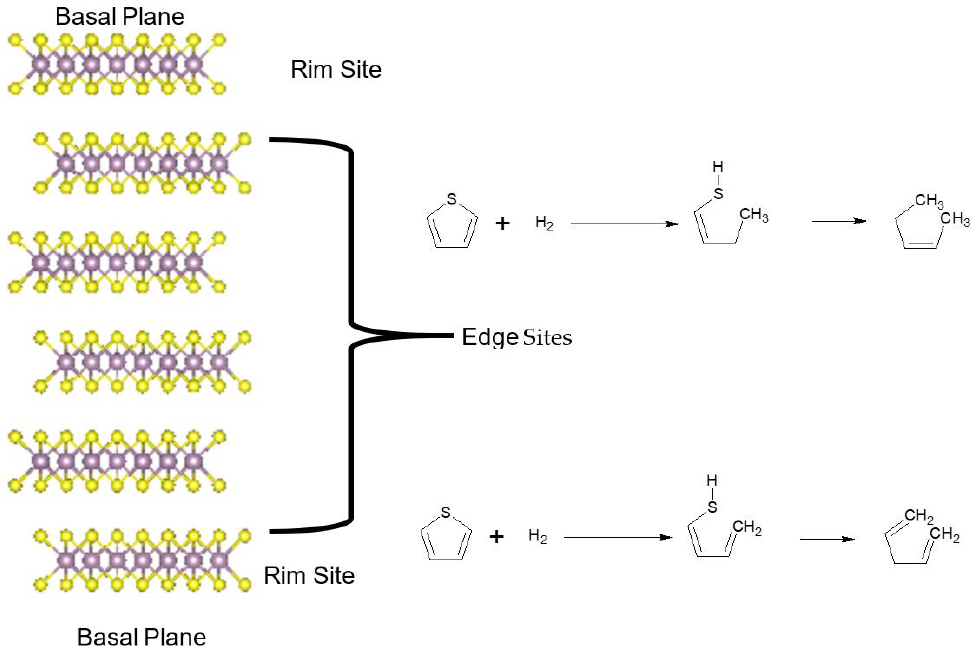
Figure 2. Break-down of the layered TMS structure into the basal planes, rim sites, and edge sites, and the HDS reaction associated with the rim and edge sites.